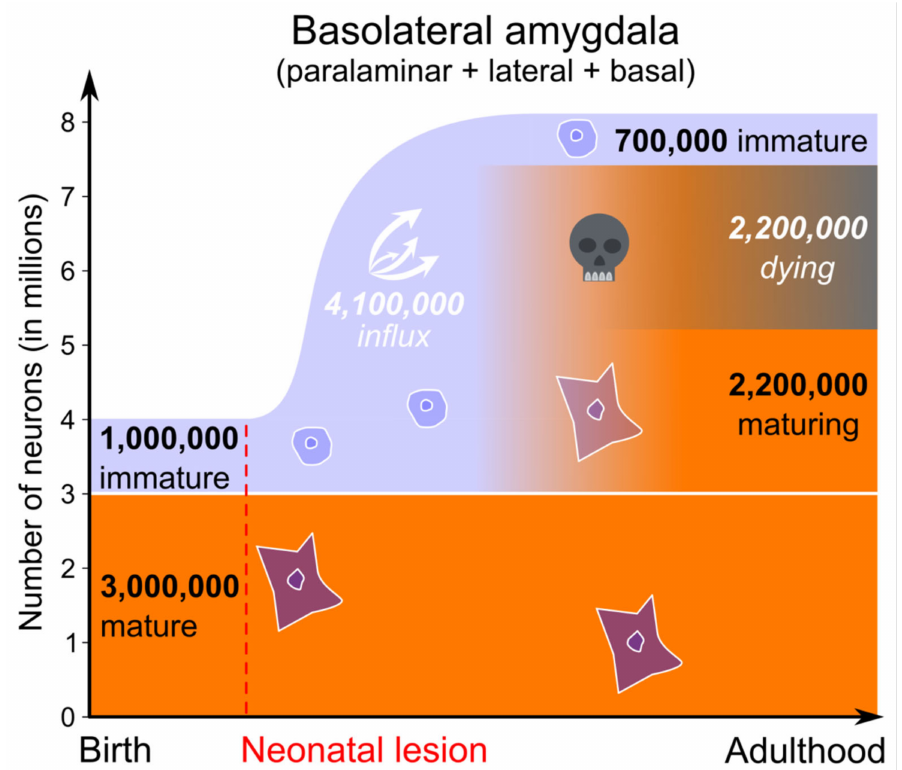
Figure 7. Proposed sequence of neuron maturation in the monkey basolateral amygdala (lateral, basal and paralaminar nuclei) following neonatal hippocampal lesion. Light blue: immature neuron population; orange: mature neuron population. The relatively low number of immature neurons present in the lateral and basal nuclei is not considered here. Numbers in white italic are speculative (number of dying and migrating cells). The number of dying cells is based on the hypothesis that ~50% of neurons die in the course of maturation (see main text). All the other cell number estimates were obtained with design-based stereological techniques applied to Nissl-stained monkey brain sections (Control monkeys n = 4; Neonatal-lesioned monkeys n = 8;